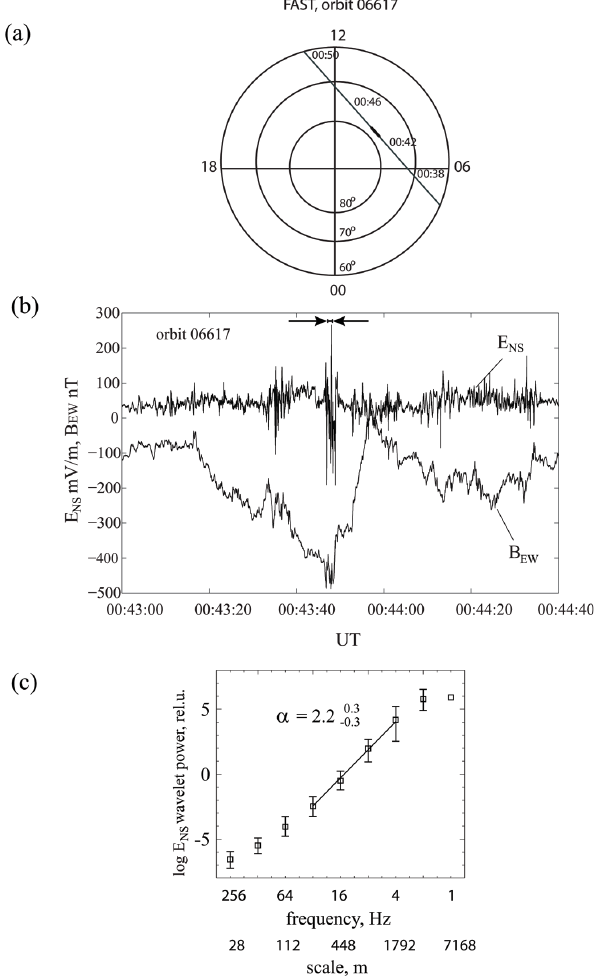
Fig. 1. (a) FAST crossing of the morning auroral zone at 1000km altitude on 25 April 1998 (orbit 06617). The time interval of interest is marked in bold; (b) FAST observations of the structured electric fields at UT=00:43:00–00:44:40. Shown are the north–south elec- tric field E NS measured with 512s − 1 sample rate and the perturba- tion of the east–west magnetic field B EW . The frequency range of magnetic observations is restricted by 8Hz from above. A horizon- tal bar with arrows indicates the position of an “isolated” electric field structure selected for the analysis; (c) plot of a wavelet power vs. scale in the log–log coordinates for the observed E NS field, con- structed with the Daubechies wavelet of the fifth order applied. The power-law dependence characterized by the slope of 2 . 2 ± 0 . 3 is in- dicated by the solid